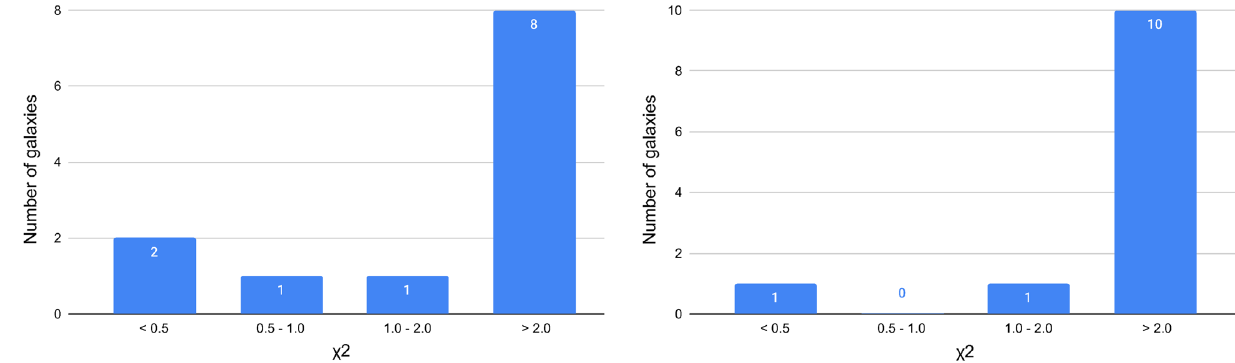
Fig. 14 Distribution of the χ 2 values for a set of 12 galaxies with R = 16 kpc, ϒ d = 0 . 5, and variable ϒ b (left panel), and R = 16 kpc, and ϒ = ϒ = 0 . 5 (right panel), respectively d b